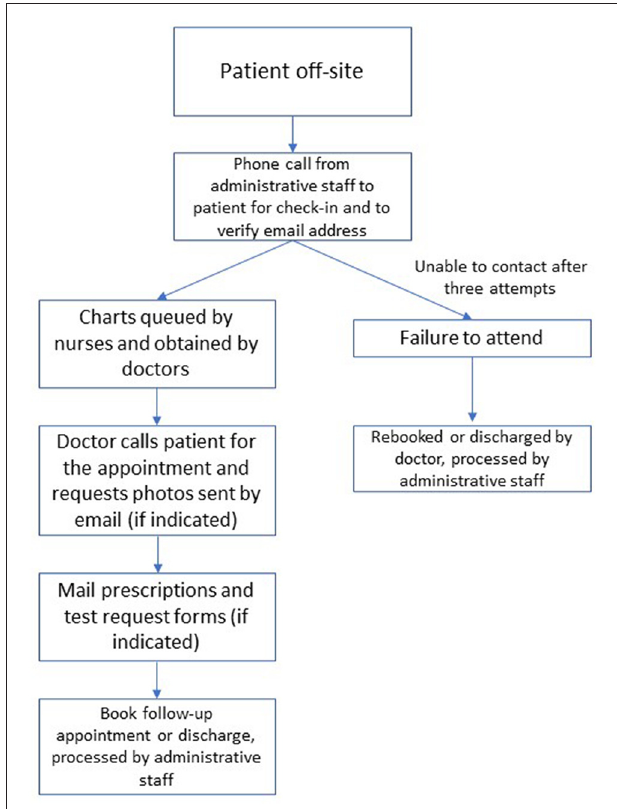
FIGURE 1 | Clinic workflow in the teledermatology